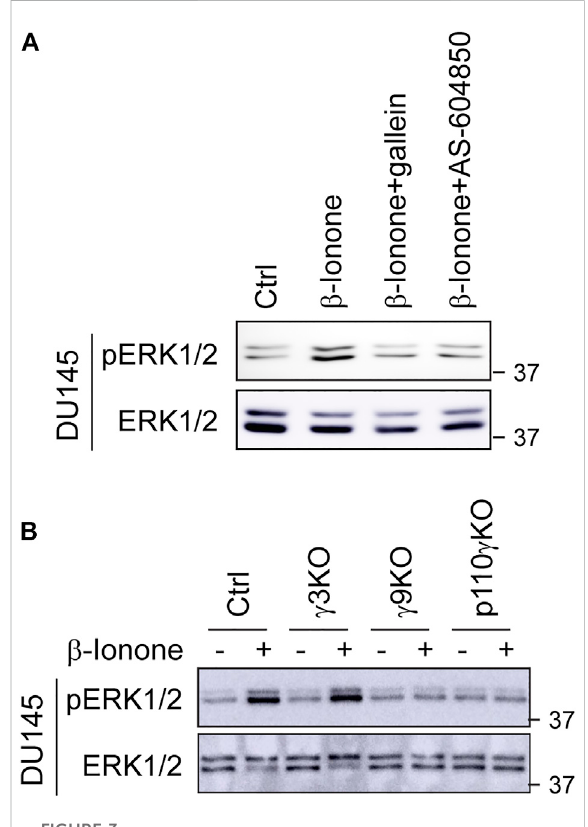
FIGURE 3 Pharmacological inhibition of G βγ and PI3K γ and CSRIPR- Cas9-mediated KO of G γ 9 and p110 γ suppress ERK1/2 activation by OR51E2. (A) Inhibition of β -ionone-mediated ERK1/2 activation byG βγ andPI3K γ inhibitors.DU145cellswerestarvedfor48 h and then treated with gallein (10 μ M for 30 min) or AS-604850 (2.5 μ M for 6 h) before stimulation with β -ionone at 100 μ M for 5 min (B) ERK1/2 activation in G γ 3, G γ 9 and p110 γ KO cells in responseto β -iononestimulation.DU145KOcellswerestarvedfor 48 h before stimulation with β -ionone. The Western blots shown are representatives of at least three